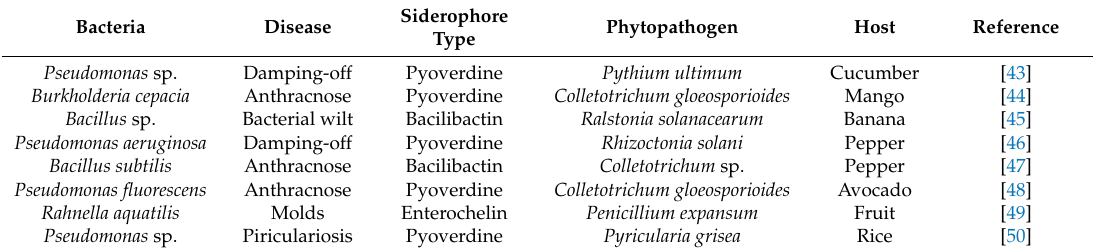
Table 3. Siderophore production by antagonistic